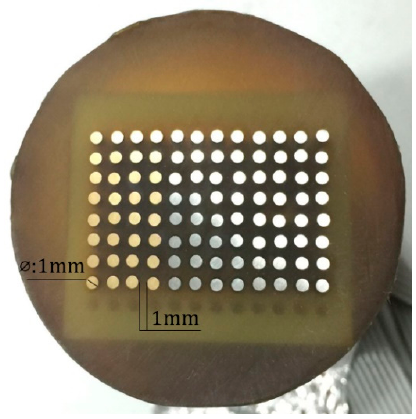
Figure 1. Coupled multielectrode array.